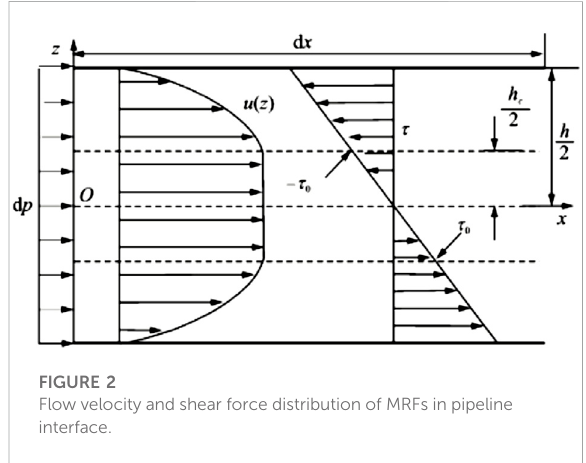
FIGURE 2 Flow velocity and shear force distribution of MRFs in pipeline